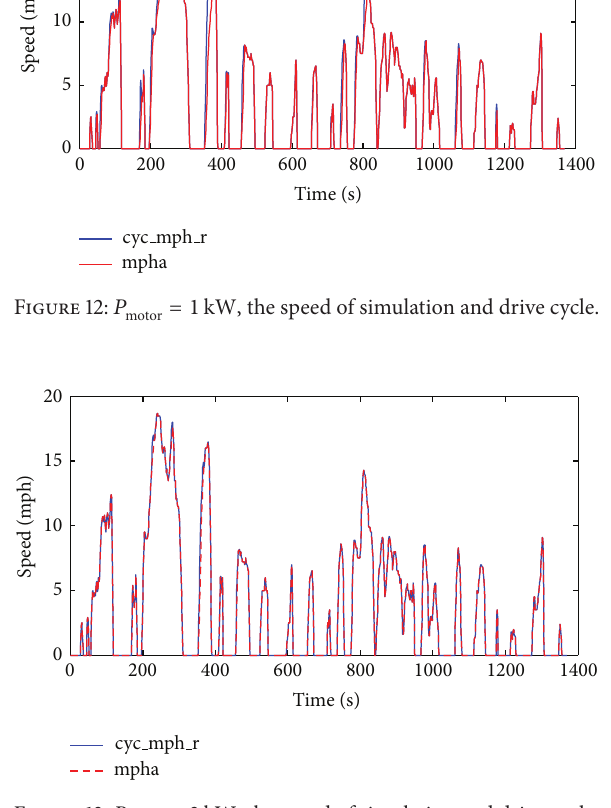
and by-products and heat transfer need time; these factors cause the stack power oscillation. Simultaneously, in order to protect the stack, DC/DC do not allow too much change of the stack power; therefore, the batteries need to provide more power [23–25]. However, ADVISOR involving mass and heat transfer is static data; therefore, the stack provides the maximum